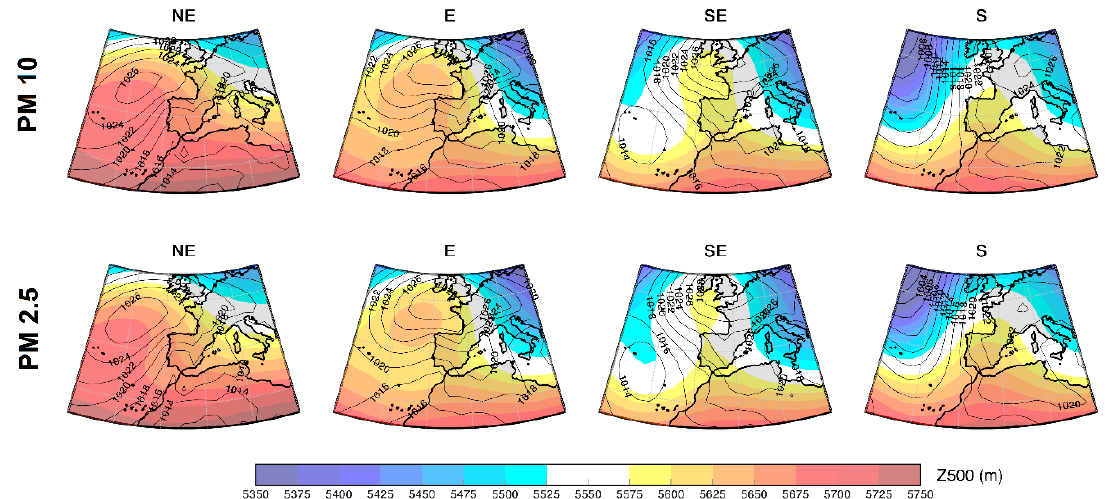
Figure 5. Composites for mean sea level pressure (MSLP) (hPa) and 500 hPa geopotential height (Z500) (m) fields for the four circulation types characterized by the highest median pollutant concentrations for the period 2006–2018. Colors show the averaged Z500 and lines display MSLP levels .